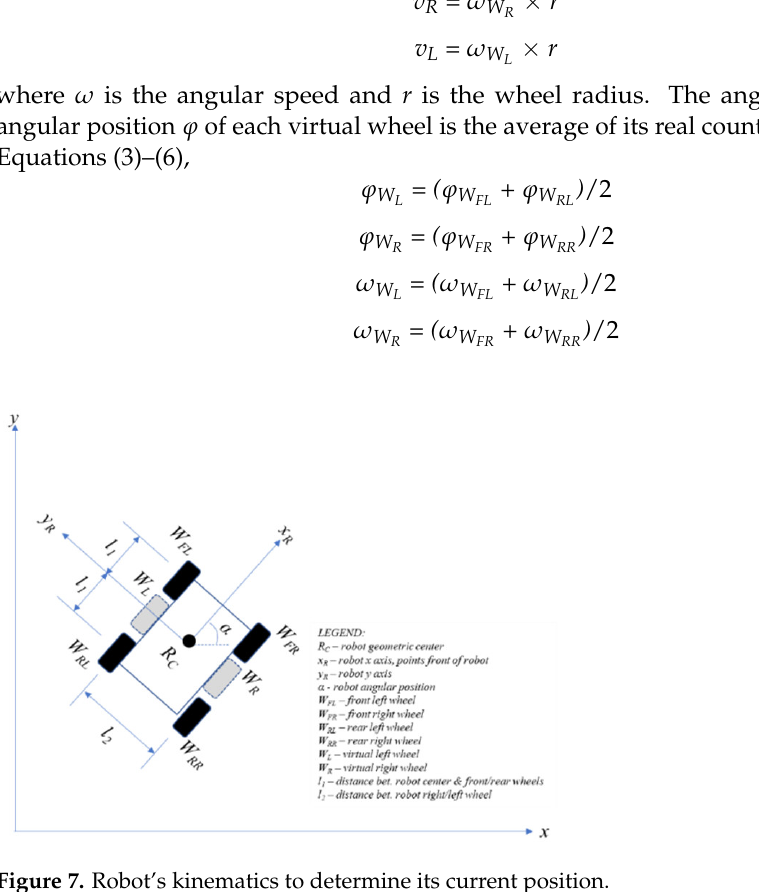
Figure 7. Robot ′ s kinematics to determine its current position. Figure 7. Robot’s kinematics to determine its current position.